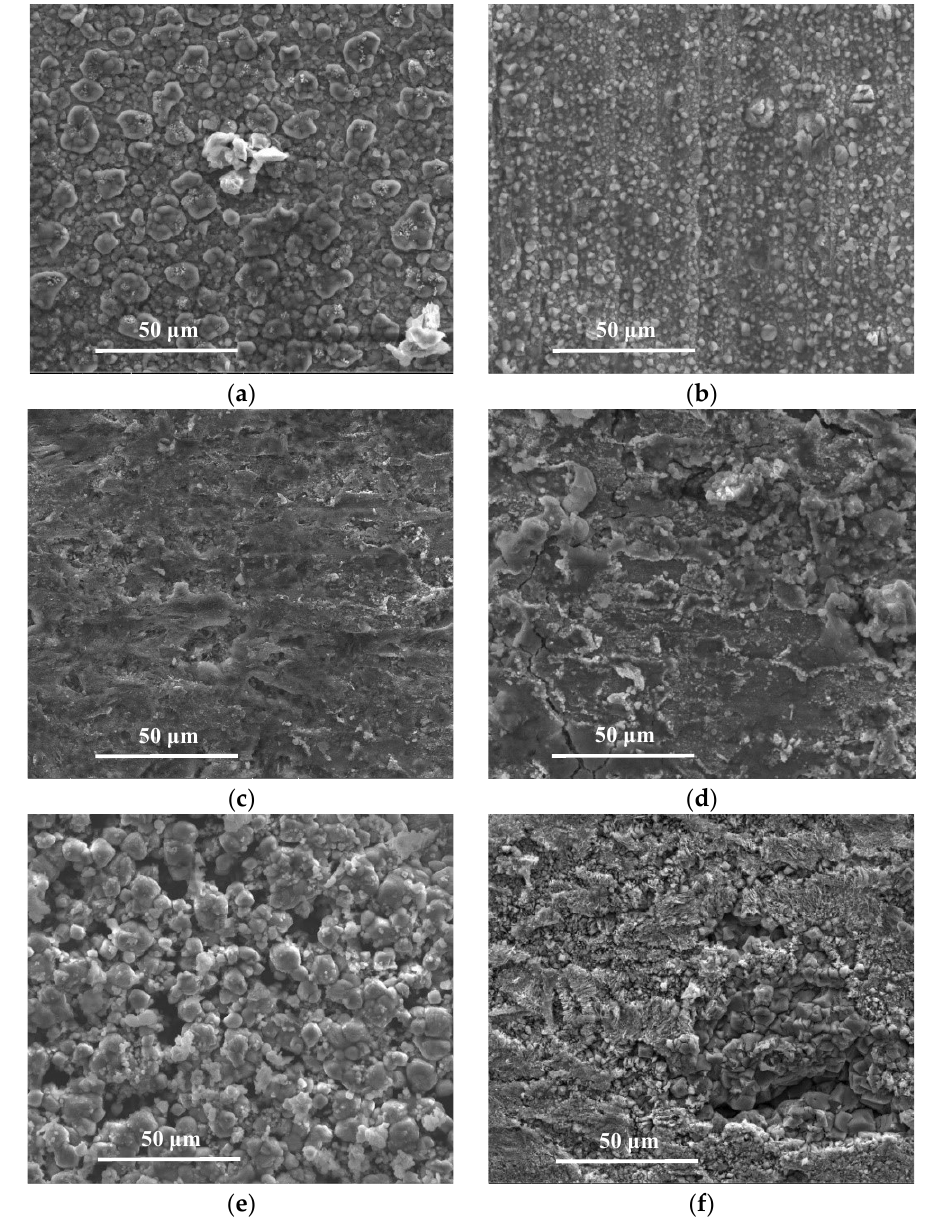
Figure 6. SEM images (2000×) of the surface morphologies of J55 steel after corrosion at ( a ) 0, ( b ) 240, ( c ) 580, ( d ) 800, ( e ) 1050, and ( f ) 1500 m